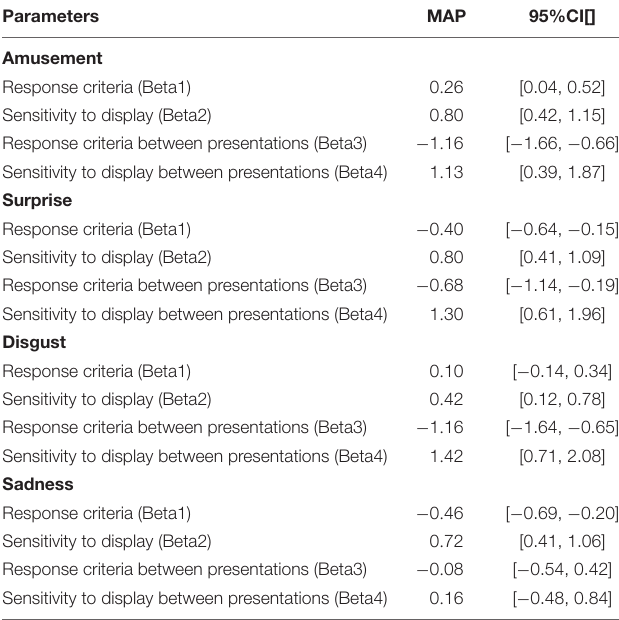
TABLE 4 | Estimated parameters on feel condition across each emotion using a Bayesian signal detection